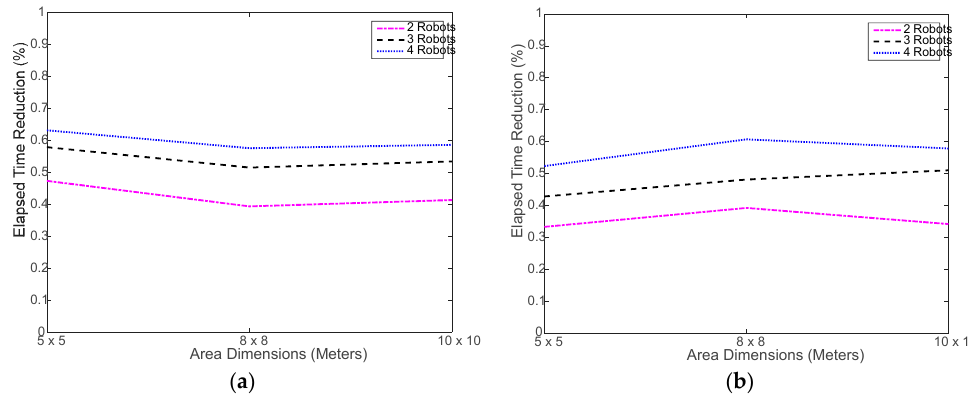
Figure 8. Elapsed time reduction in experimental testing: ( a ) using distributed WiMAP algorithm; ( b ) using distributed DWiMAP.